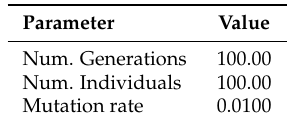
Figure 4. Evaluation of the proposed heuristics to solve the ENPP. Table 4. Input parameters for the Evolutionary Algorithm.